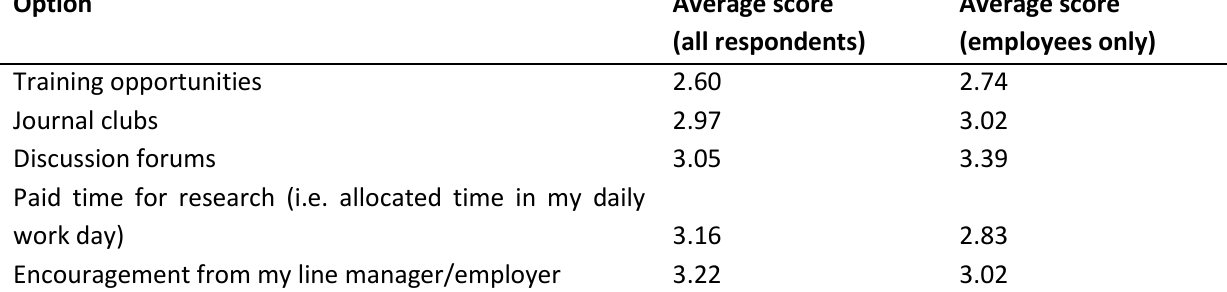
Table 12 : Methods of increasing the adoption of EBVM Option